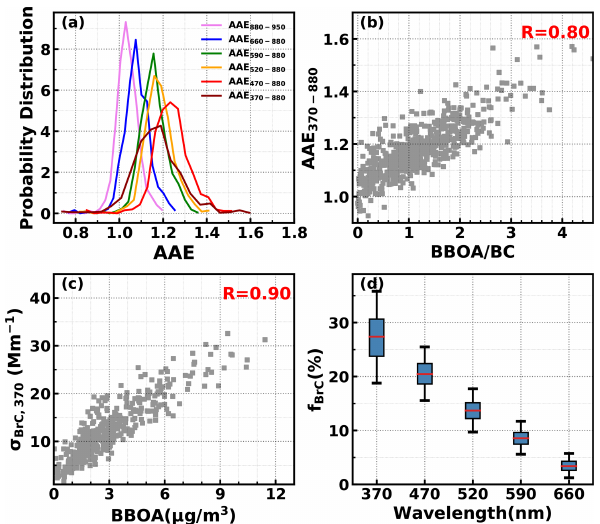
Figure 2. (a) Probability distribution of AAE between different wavelengths and 880nm. (b) Correlations between AAE 370–880 and mass ratio of BBOA and BC. (c) Correlations between the BrC absorption coefficients at 370nm and the BBOA mass loadings. (d) Box-and-whisker plots of BrC absorption fractions at different